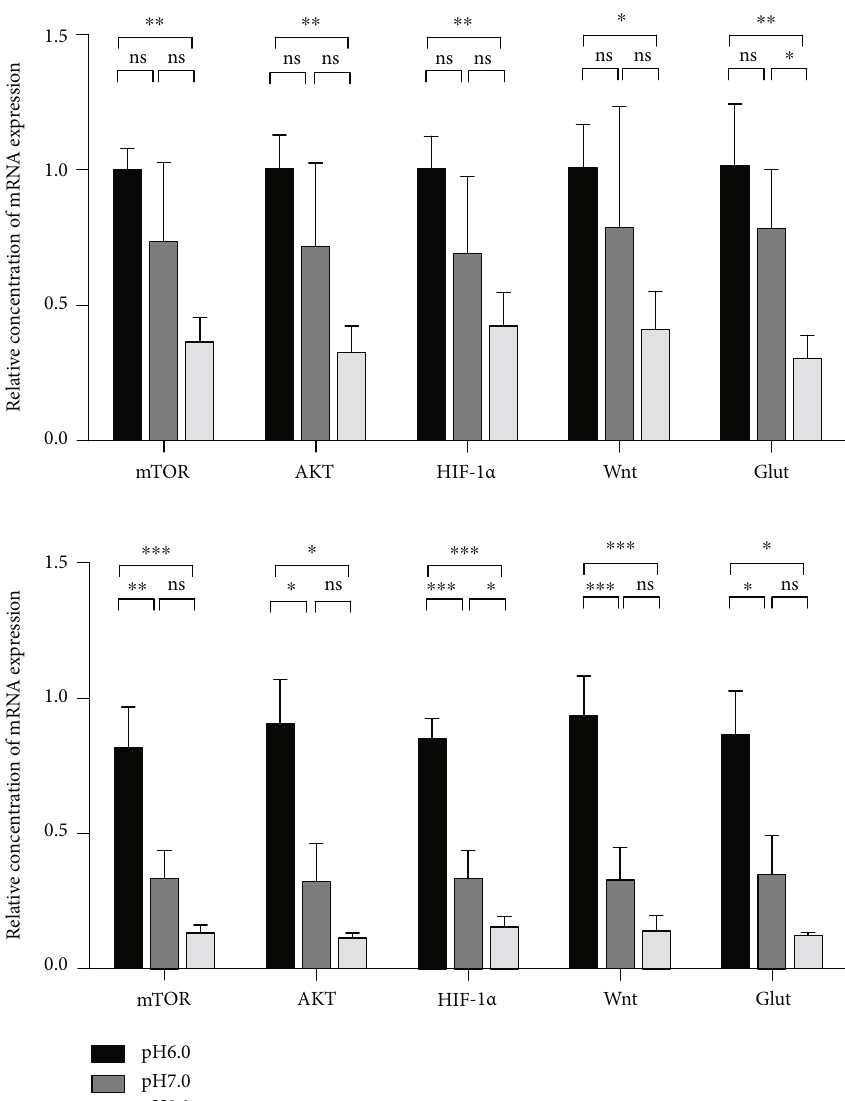
Figure 4: Alkaline microenvironment inhibited the expression of genes (mTOR, AKT, HIF-1 α , Wnt, and Glut). (a) qRT-PCR detected the expression of genes (mTOR, AKT, HIF-1 α , Wnt, and Glut) in GC cells (SGC-7901 and MKN45) at di ff erent pH values (pH6.0, pH 7.0, and pH8.0) after being cultured for